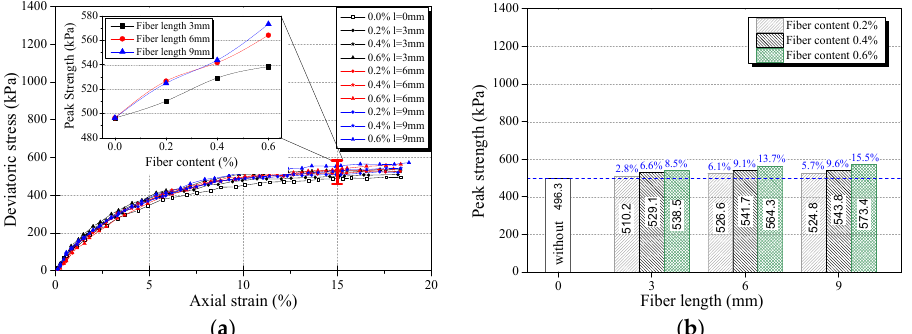
Figure 6. Stress strain curve and peak strength of fiber-reinforced tailings clay ( ρ d = 1.52 g · cm − 3 ). ( a ) Stress-strain curve, ( b ) peak strength increment of